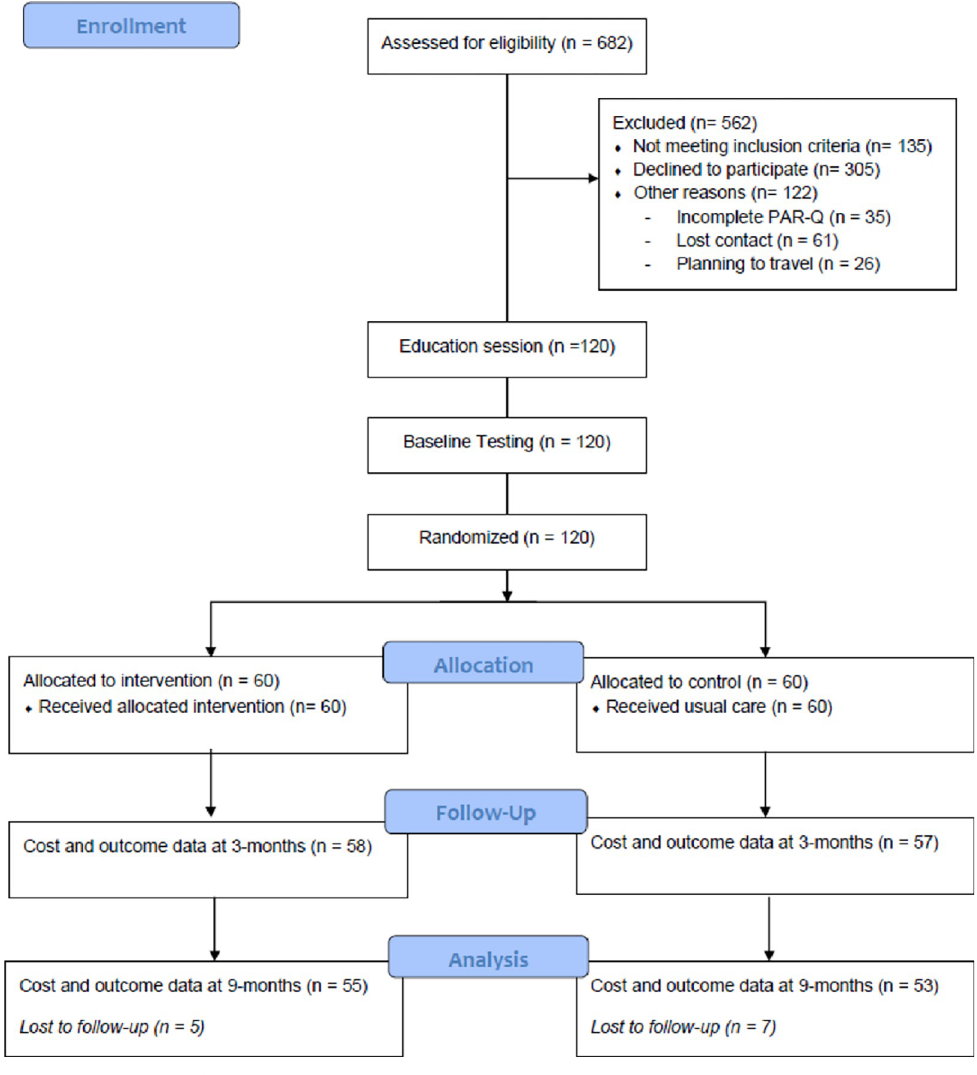
Fig 1. CONSORT flow